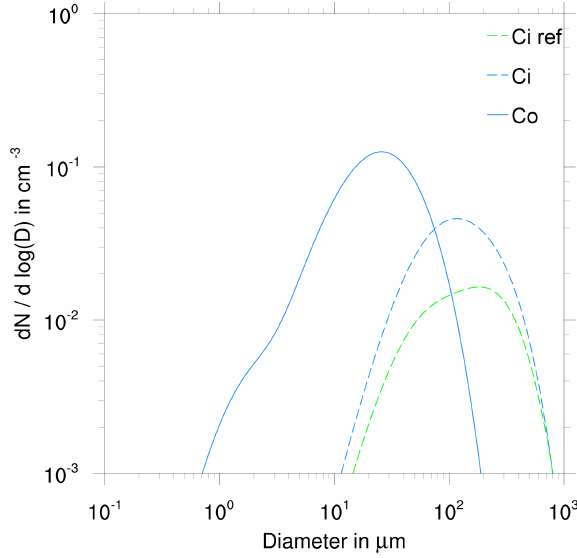
Figure 1. Ice crystal size distribution of the simulation with (blue) and without (green) aviation. For the simulation with aviation, sep- arate ASDs of the contrail and cirrus ice class are shown (solid and dotted line). Time is